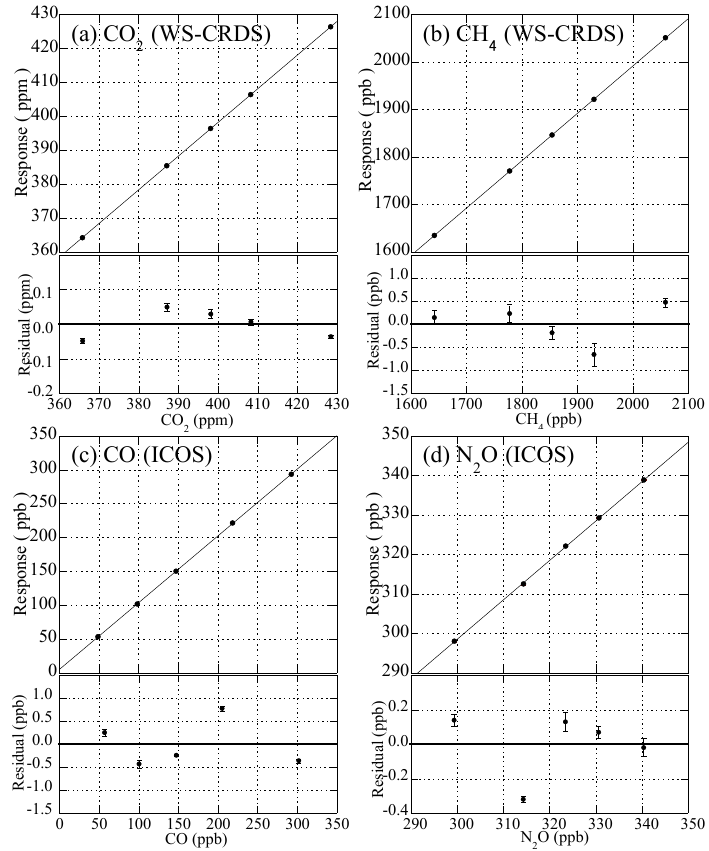
Fig. 4. Plots of the analyzer response versus assigned mole fractions of 5 working standard gases for CO 2 (a) and CH 4 (b) of the WS-CRDS analyzer, and CO (c) and N 2 O (d) of the ICOS analyzer. The solid line represents a linear least squares fit to all the data points. Residuals of the fit are plotted in the lower